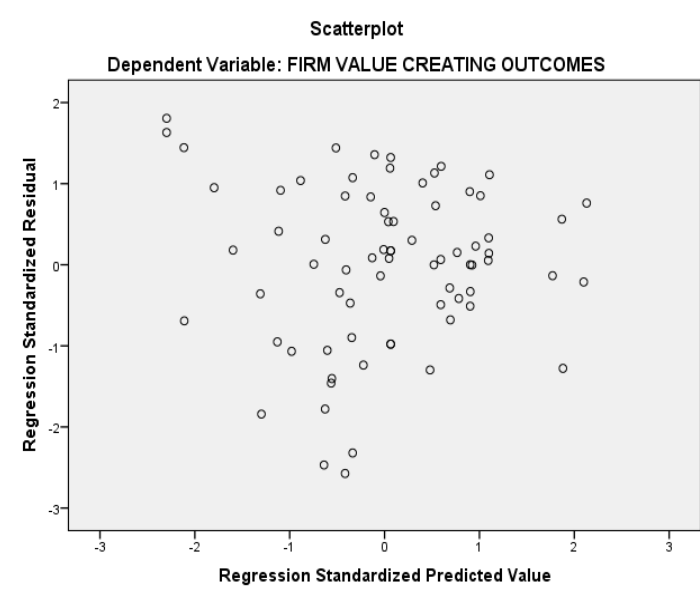
Test for heteroskedasticity on shareholder loyalty